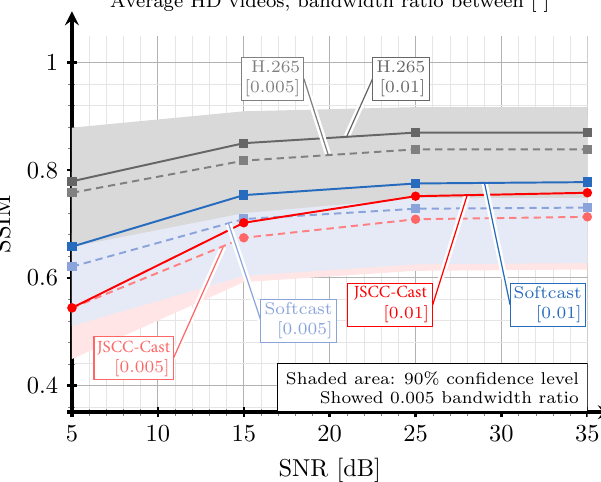
Figure 12. SSIM versus SNR for a selection of videos with full HD resolution extracted from [39]. The red lines correspond to the proposed JSCC-Cast, the blue lines to Softcast, and the grey lines to H.265. The solid lines correspond to a bandwidth ratio of 0.1, and the dashed lines correspond to a bandwidth ratio of 0.05.